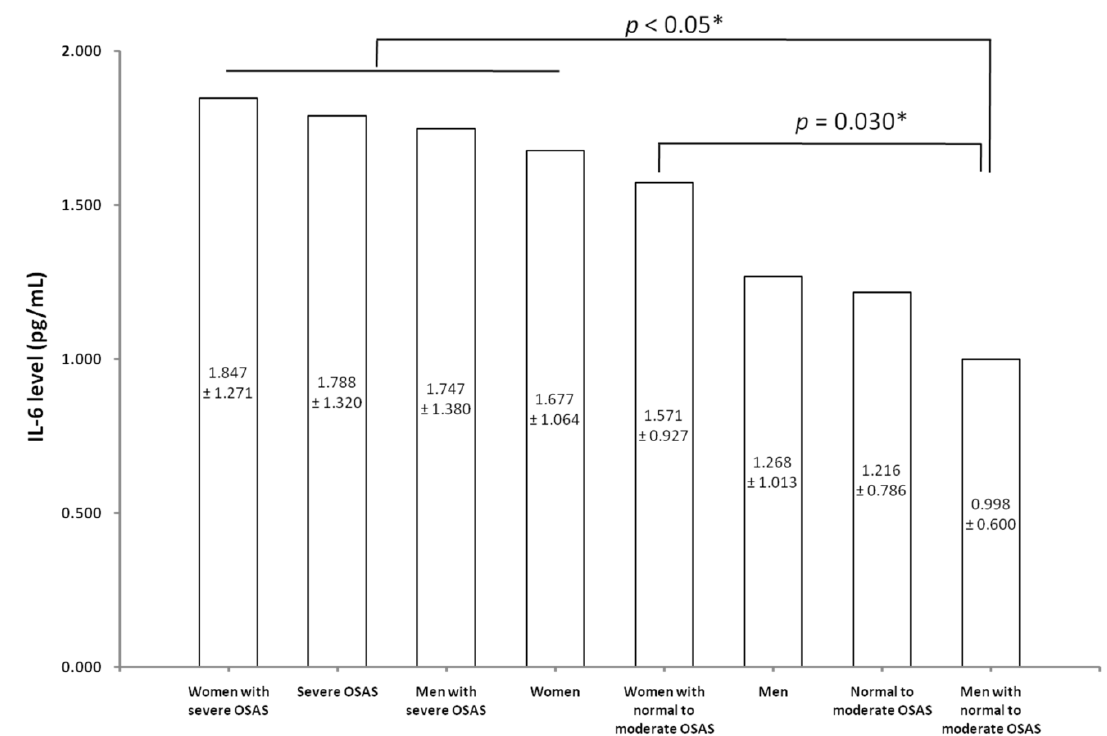
Figure 2. The validation results of the interaction effects between OSAS severity and sex on the level of IL-6. All data are expressed as mean and standard deviation at a significant difference with a p -value <0.05 (*). Abbreviations: IL-6, interleukin-6; OSAS, obstructive sleep apnea syndrome.